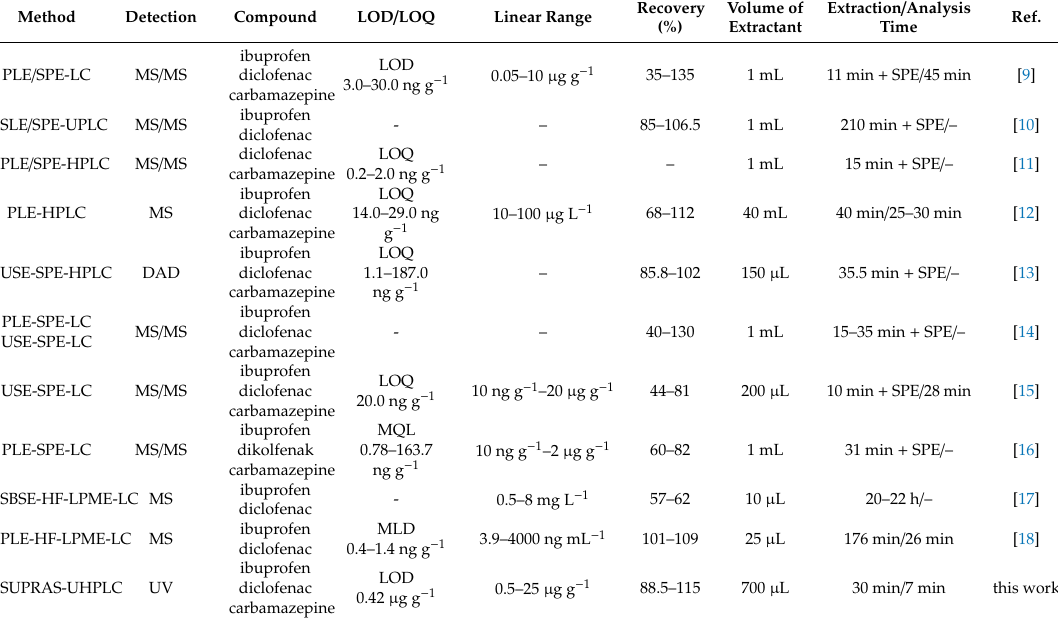
Table 3. Comparison of the developed SUPRAS microextraction method with other methods to extract drugs from sediment samples described in the literature.